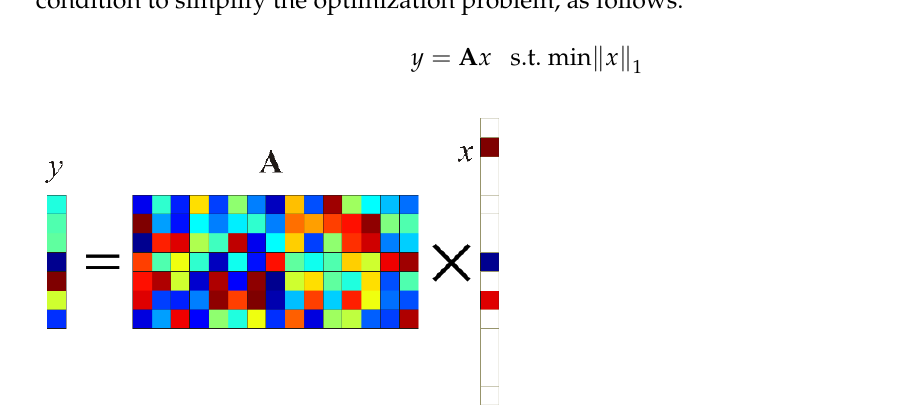
Figure 3. Demonstration of sparse representation.